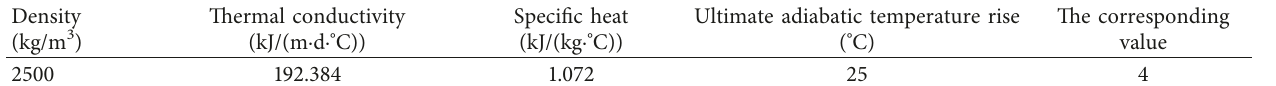
Table 8: The related parameters of the dam.